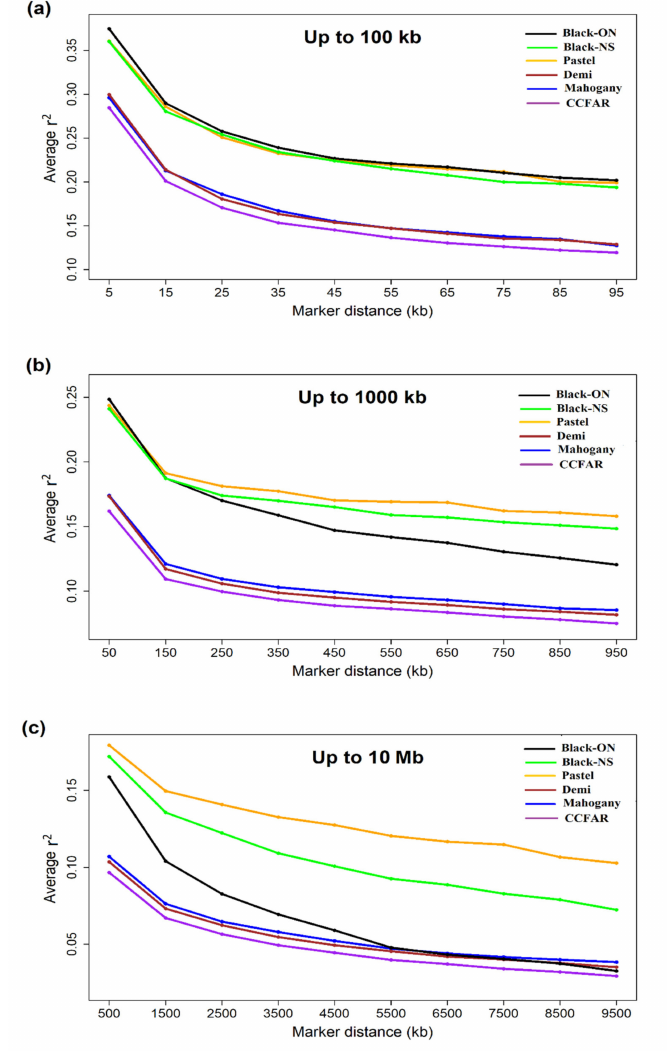
Figure 3. Linkage disequilibrium (LD) decays represented by the average r 2 for inter-marker distances of ( a ) up to 100 kb using consecutive 10 kb bins ( b ) up to 1000 kb using consecutive 100 kb bins and ( c ) up to 10 Mb using consecutive 1000 kb bins. Black-NS and Black-ON represent the black color-type samples collected from the Canadian Center for Fur Animal Research (Truro, NS, Canada) and Millbank Fur Farm (Rockwood, ON, Canada),